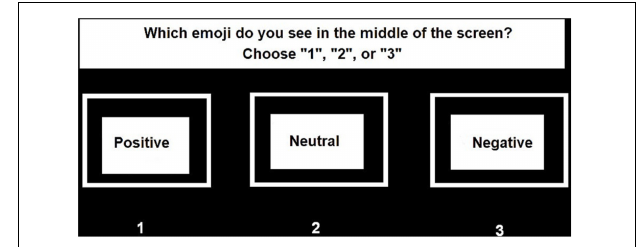
FIGURE 3 | Response screen valence of the central Emoji. Note: based on Van Beveren et al. (2020).